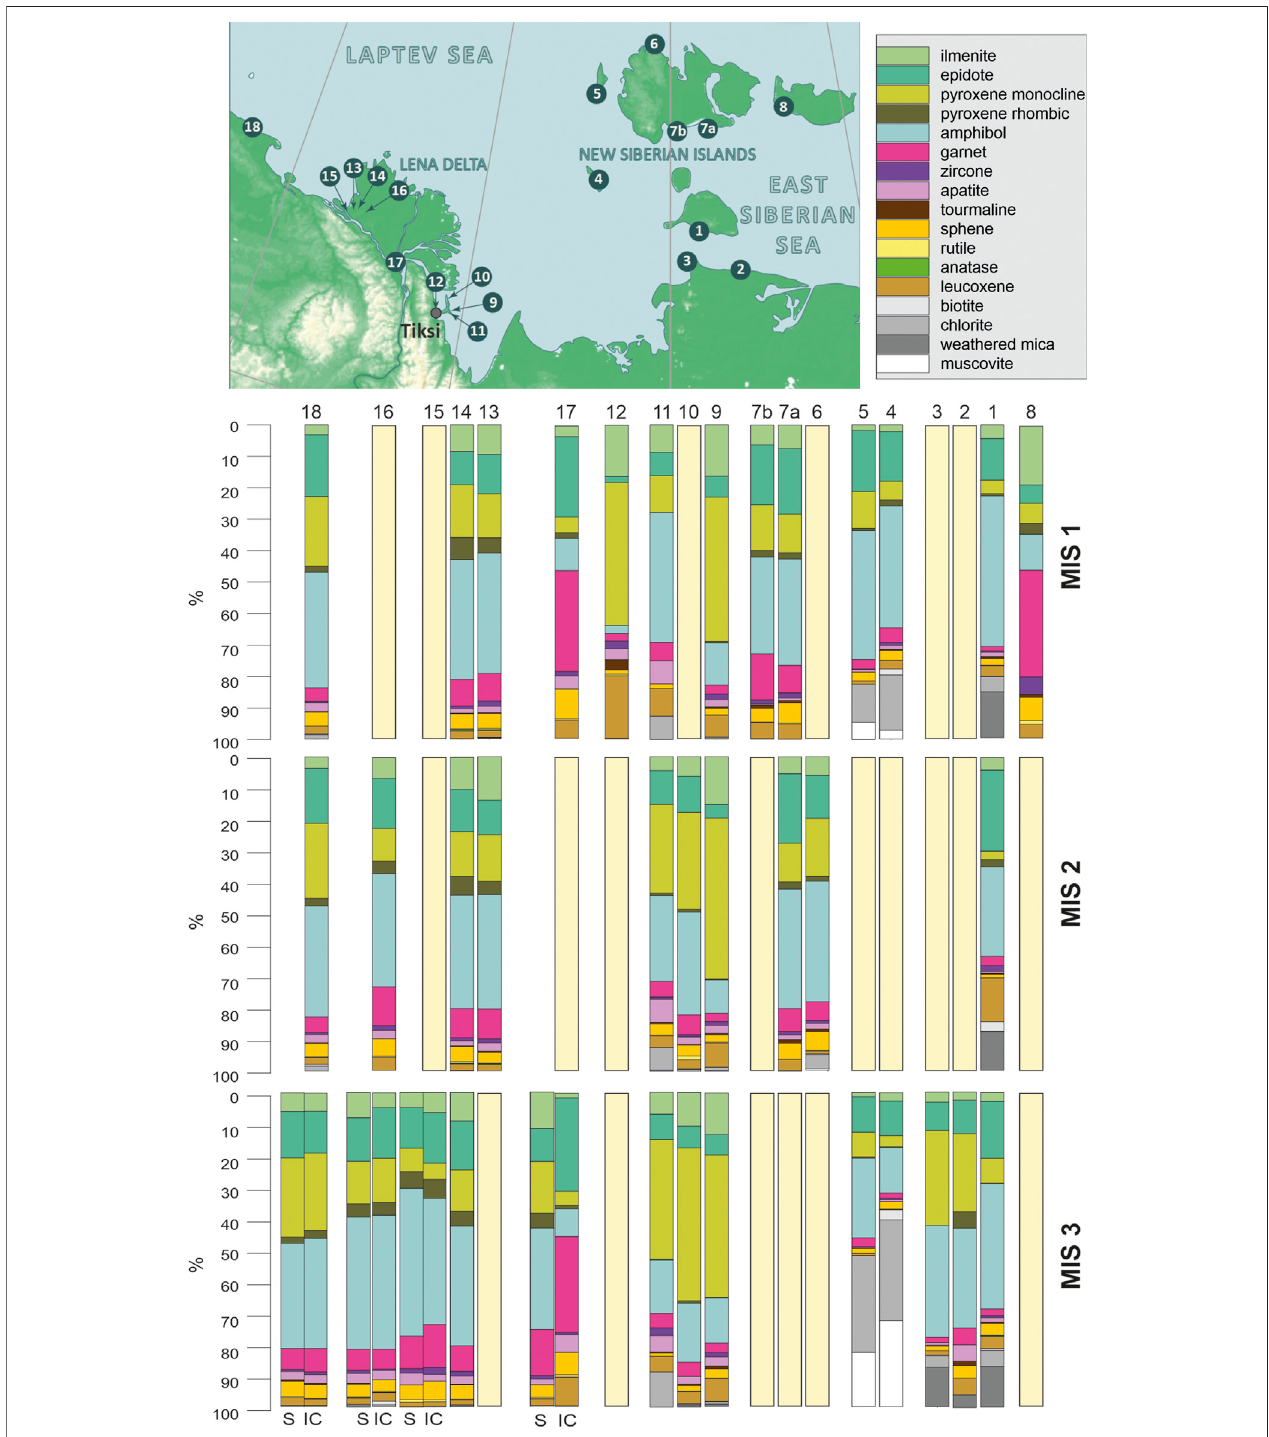
FIGURE 8 | Regional comparison of the best studied heavy minerals association (63 – 125 µm) in the most widespread stratigraphic units (MIS 3, 2 and 1). For the light-yellow boxes are no data available. The map is a cutout from the map of Figure 1 . (1 — Bol ’ shoy Lyakhovsky Island; 2 — Oyogos Yar coast; 3 — Cape Syatoy Nos; 4 — Stolbovoy Island; 5 — Bel ’ kovsky Island; 6 — Cape Anisii, Kotel ’ ny Island; 7 — Bunge Land (a — higher terrace, b — lower terrace); 8 — Novaya Sibir ’ Island. Bykhovsky Peninsula: 9 — Mamontovy Khayata; 10 — Bykovsky North; 11 — Ivashkina Lagoon; 12 — Khorogor Valley. Lena Delta: 13 — eastern Ebe Basyn Island; 14 — Turakh Island; 15 — Nagym, southern Ebe Basyn Island; 16 — Khardang Island; 17 — Kurungnakh Island; 18 — Cape Mamontov Klyk).